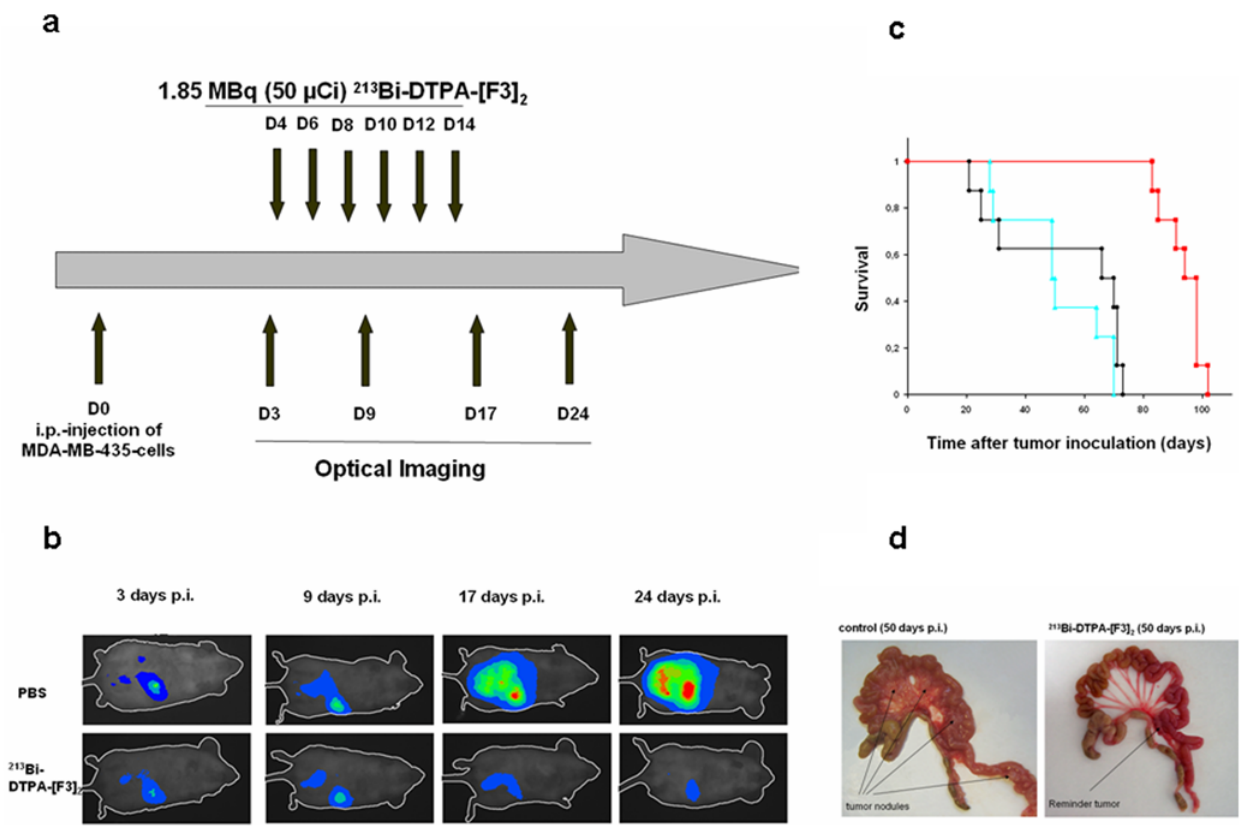
Figure 4. Tumor prevention study. (a) The scheme depicts the time points when 213 Bi-DTPA-[F3] 2 , 213 Bi-DTPA or PBS were injected and the time points when optical imaging was performed. (b) Assessment of the tumor growth of MDA-MB-435luc2 xenograft tumors by optical imaging in a mouse treated with 213 Bi-DTPA-[F3] 2 or in a control mouse treated with PBS. (c) Kaplan-Meier analysis of the survival of mice with intraperitoneal tumors treated with 213 Bi-DTPA-[F3] 2 (red), 213 Bi-DTPA (green) or PBS (black). (d) Macroscopic picture of small intestine and colon of tumor bearing mice treated like those of the tumor prevention study with 213 Bi-DTPA-[F3] 2 and PBS (control) 50 days after inoculation with MDA-MB-435 cells i.p.